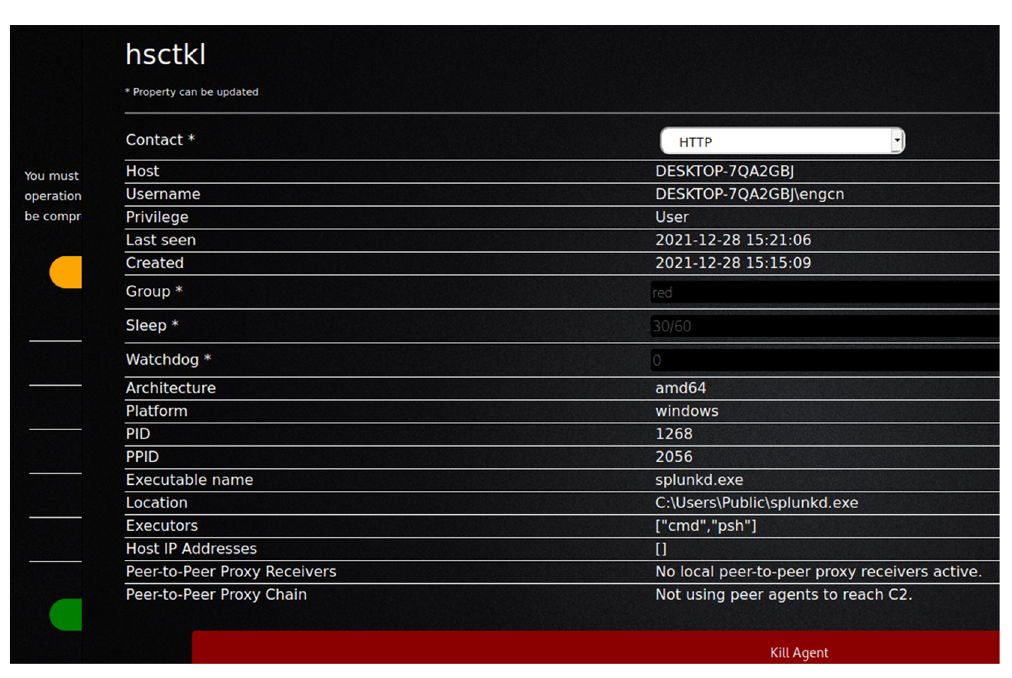
Figure 6. Bypassing Windows Security (connected with victim machine and take over through the